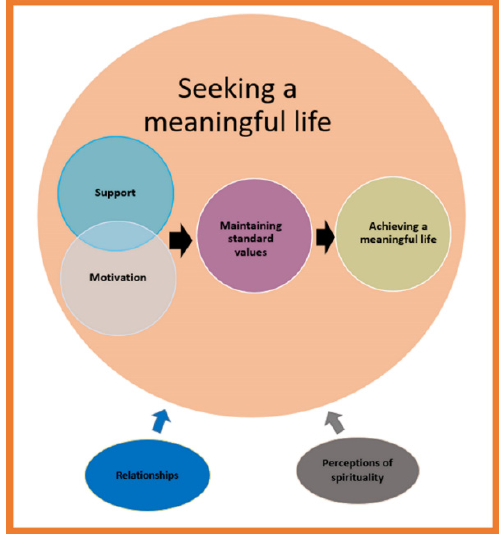
Figure 1. The core category seeking a meaningful life. Frame: the core category seeking a meaningful life; large circle: the three-stage process, with the small circles indicating condition, action and consequences and arrows for the direction of the process; oval: the contextual categories, with two arrows for supporting and intervening factors.